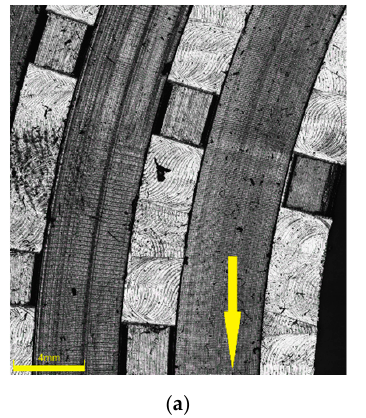
Table 3. Reduction of grinding